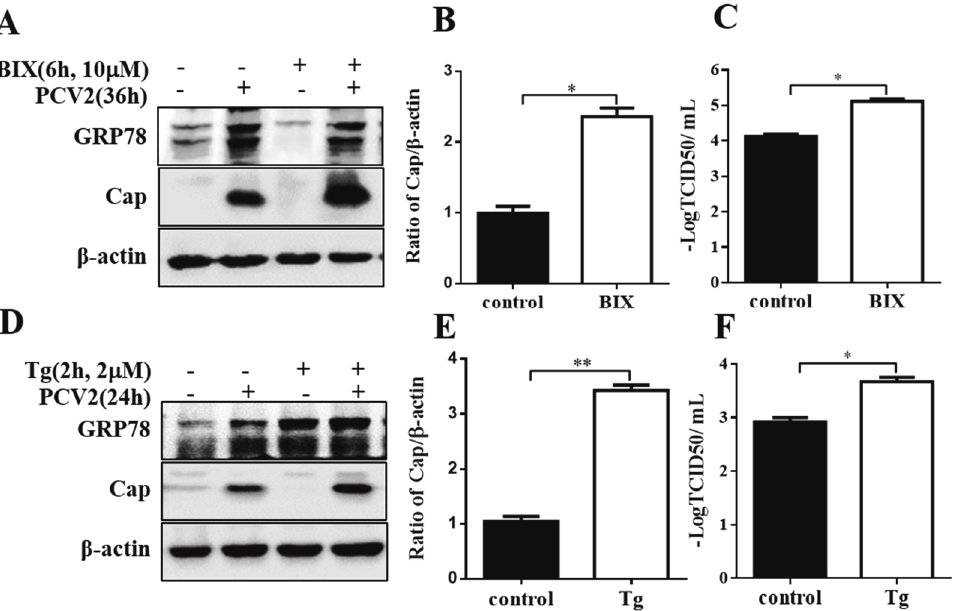
Figure 5. Induction of GRP78 by pretreatment with BIX or thapsigargin enhanced viral capsid protein expression. PK-15 cells were pre-treated with 10 µ M GRP78 inducer BIX for 6 h or with 2 µ M thapsigargin (Tg) for 2 h and then infected with PCV2 (MOI = 1) in fresh medium for another 36 h or 24 h. Whole cell lysates were then subjected to Western blotting for GRP78, Cap and β -actin. ( A , D ) Representative blot showing the effects of GRP78 induction by BIX or thapsigargin on viral capsid (Cap) protein expression; ( B , E ) Ratio of Cap to β -actin normalized to control cells set at 1.0; ( C , F ) Effects of GRP78 induction by BIX or thapsigargin on virus titer expressed as log TCID 50 /mL.